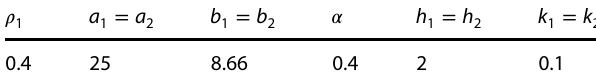
Table 3 Parameter values for the control law